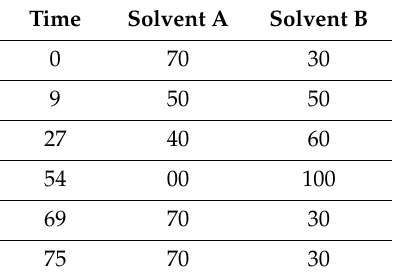
Table 7. The mobile phase and the gradient